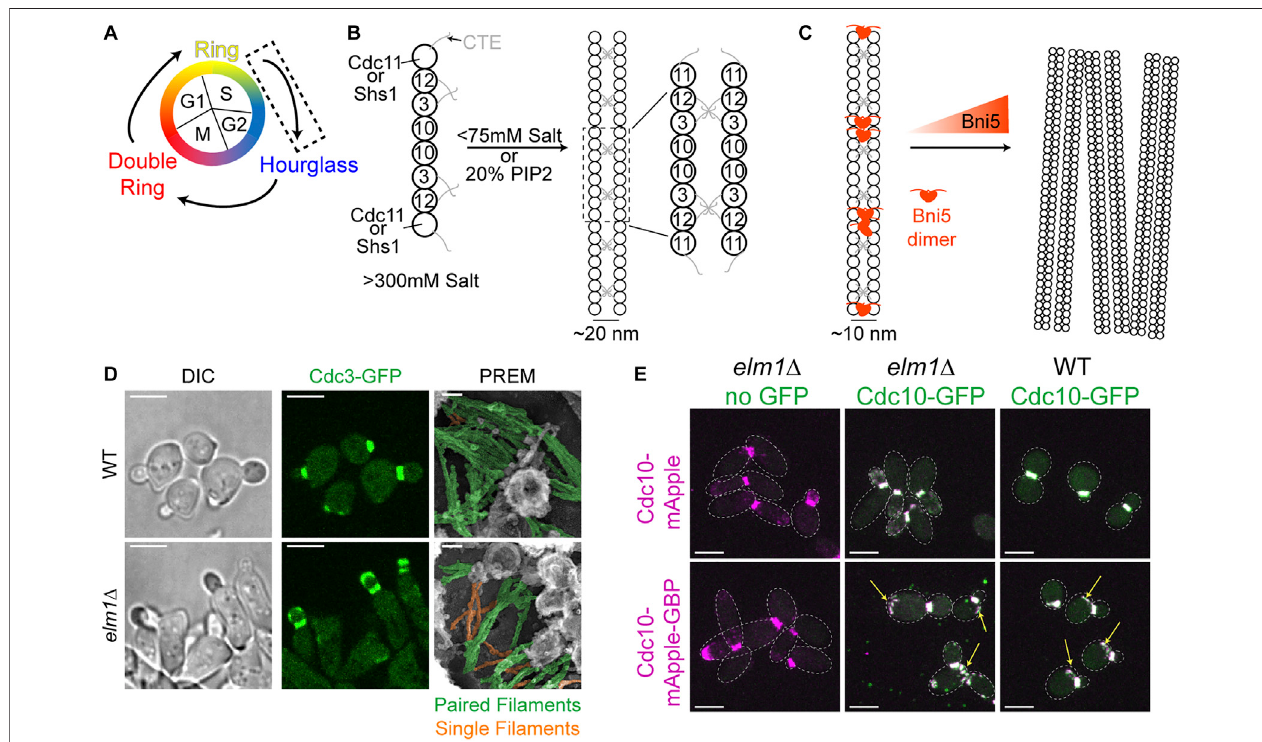
FIGURE1| Transitioningfromadynamicringtoastablehourglass. (A) Depictionofdifferentseptinstructuresvisualizedduringtheyeastcellcycle.Arrowsindicate transitions occurring between two structures. Dashed box indicates that the focus of this fi gure is on the nascent ring-to-hourglass transition that occurs during bud emergenceandexpansion. (B)Left ,depictionofseptinrodassemblyinhighsalt( > 300 mMKClorNaCl) invitro (Frazieretal.,1998;Bertinetal.,2008). Right ,depiction of Cdc11-capped rods forming paired fi laments in either low salt ( < 75 mM) (Bertin et al., 2008) or on the surface of PIP2-containing lipid monolayers (Bertin et al., 2010; Bridges et al., 2014); dashed box indicates zoomed in inset shown to the right. (C) Left , depiction of two Bni5 proteins (red molecules) interacting with Cdc11- CTEs found in paired septin fi laments to lower the average inter fi lament distance to 10 nm (Finnigan et al., 2015; Booth et al., 2016). Right , depiction of Bni5 bundling septin fi lamentsintolargeclusters invitro inadose-dependentmanner(Patasietal.,2015). (D) RepresentativeimagesofWT (top) or elm1 Δ (bottom) cellssynchronized in G1 by α -factor arrest and released for 1.5 h to obtain small-to medium-sized buds. Left and middle panels show DIC and fl uorescence imaging of Cdc3 (green), respectively;scalebars (cid:1) 5 µm. Rightpanels showPREMimagesofsampleswithpaired fi lamentspseudo-coloredgreenandsingle fi lamentspseudo-coloredorange; scale bars (cid:1) 50 nm. Images taken from (Marquardt et al., 2020). (E) Representative images of indicated strains with Cdc10-mApple (top row) or Cdc10-mApple-GBP (bottom row) in magenta and Cdc10-GFP, which is expressed exogenously from a CEN plasmid, in green. Images are maximum projections. Yellow arrow indicates septin ring from previous cell cycle. Dotted line is cell periphery. Scale bars (cid:1) 5 µm. Images taken from (Marquardt et al., 2020).